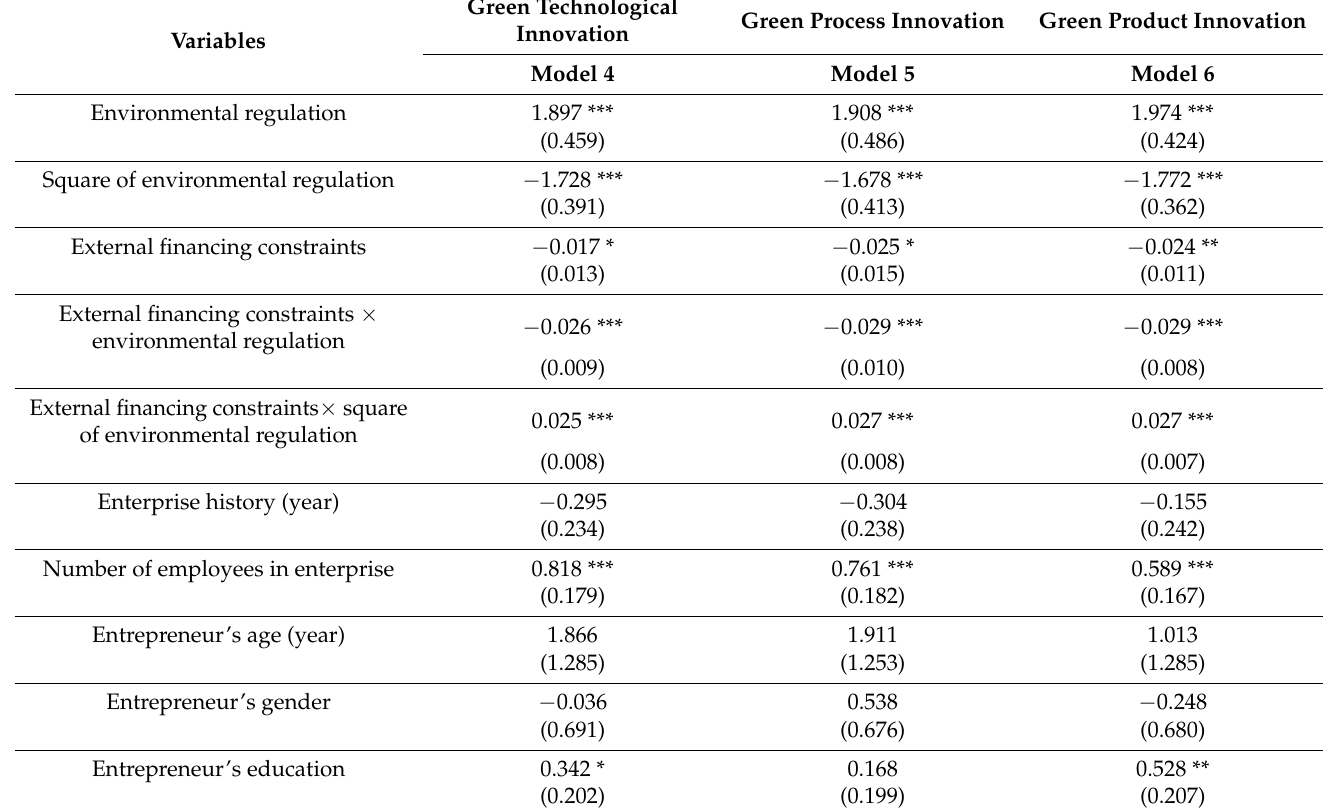
Table 4. Moderating effect of external financing constraints on the relationship between environmen- tal regulation and enterprise green process